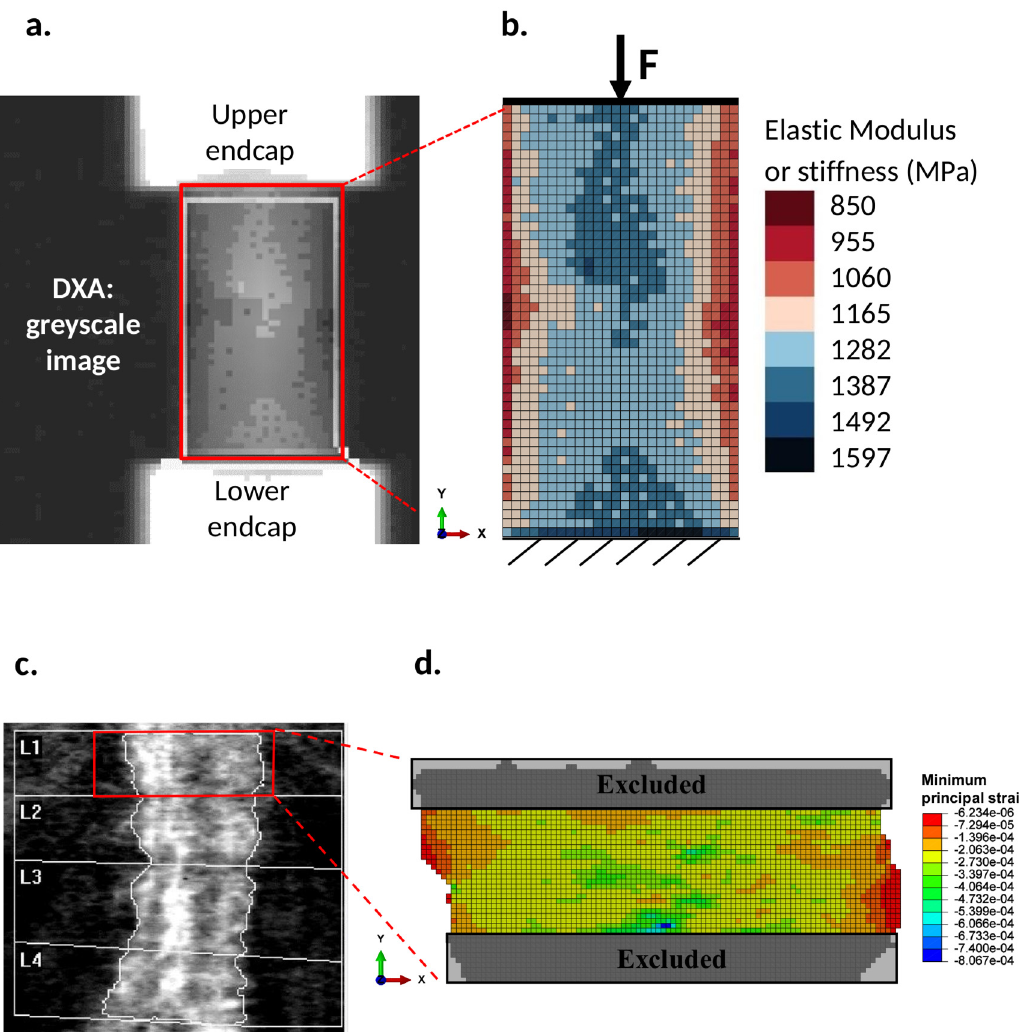
colour bar. c) Greyscale image obtained from a DXA of a spine from a patient fractured not in the lumbar area (corresponding to P3 in Table 2). b) Example of minimum principal strain ( ε